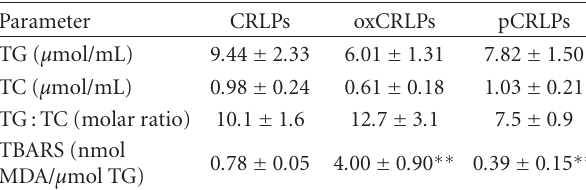
Table 1: Lipids and TBARS content of